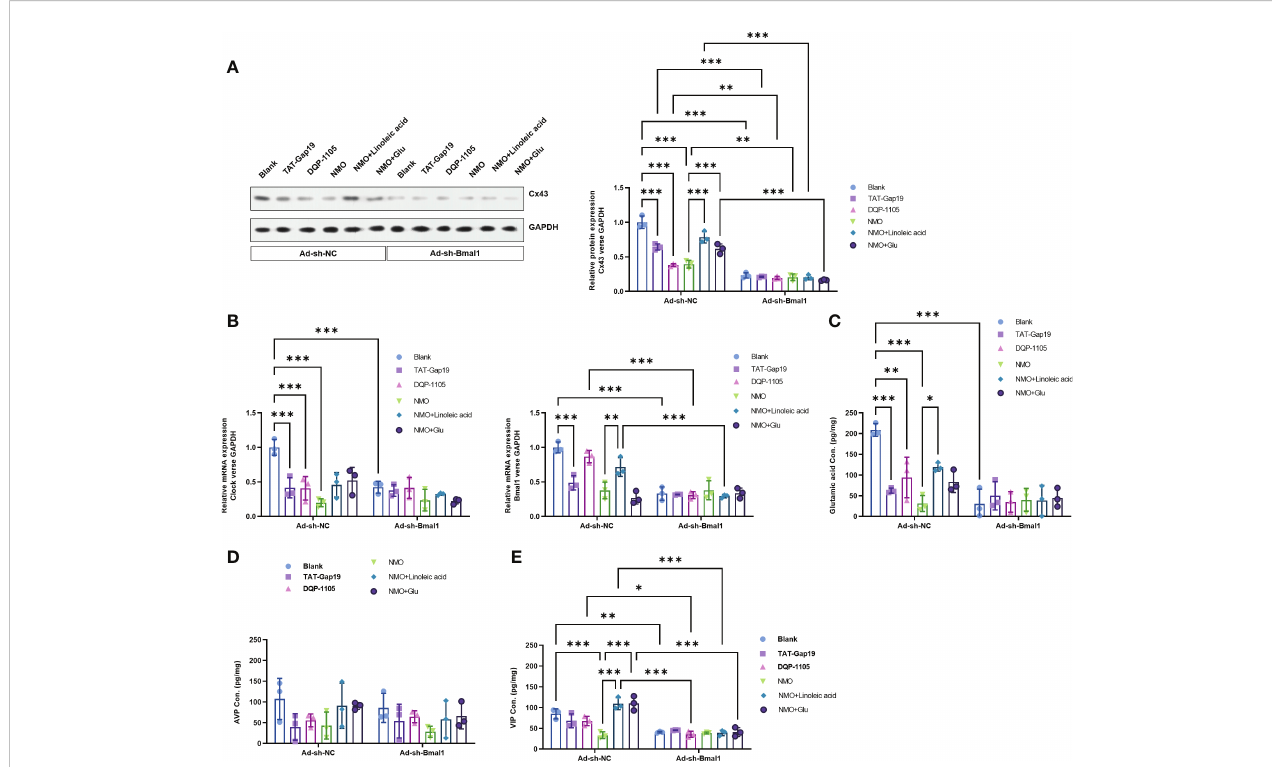
FIGURE 5 Bmal1 knockdown reversed the Cx43-glutamate signaling activation. (A) The effect of Bmal1 knock-down on the protein level of Cx43 in normal astrocytes with or without TAT-Gap19/DQP-1105 or NMO astrocytes with or without LA/glutamate were analyzed by Western Blot. (B) The effect of Bmal1 knock-down on the mRNA levels of Clock and Bmal1 in normal astrocytes with or without TAT-Gap19/DQP-1105 or NMO astrocytes with or without LA/glutamate were analyzed by real-time PCR. (C) The effect of Bmal1 knock-down on the glutamate levels in normal astrocytes with or without TAT-Gap19/DQP-1105 or NMO astrocytes with or without LA/glutamate were analyzed by ELISA kit. The effect of Bmal1 knockdown on the protein level of AVP (D) and VIP (E) was detected by ELISA kits. * P <0.05, ** P <0.01, *** P <0.001, compared with the indicated group.